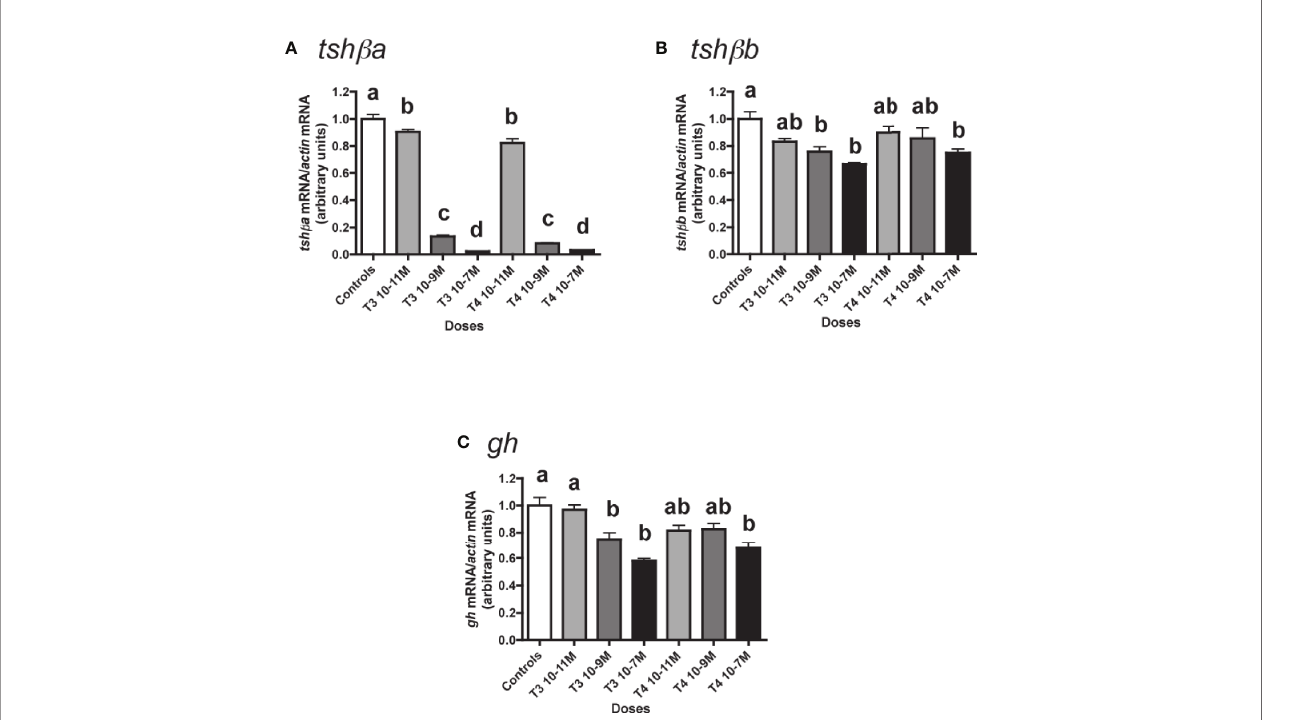
FIGURE 1 | Effects of thyroid hormones (T3 and T4) on tsh b a , tsh b b , and gh transcript levels in primary cultures of Atlantic salmon pituitary cells. Pituitary cells from juvenile Atlantic salmons were treated with various concentrations of T3 or T4 for 10 days. The mRNA levels of tsh b a (A) , tsh b b (B) , and gh (C) were quanti fi ed by qPCR. Data were normalized against b -actin . The Figure displays the results from a representative experiment of three ( tsh b b ) or fi ve ( tsh b a and gh ) independent cell culture experiments. Mean ± SEM; n = 5 well replicates. Different letters indicate signi fi cant differences,